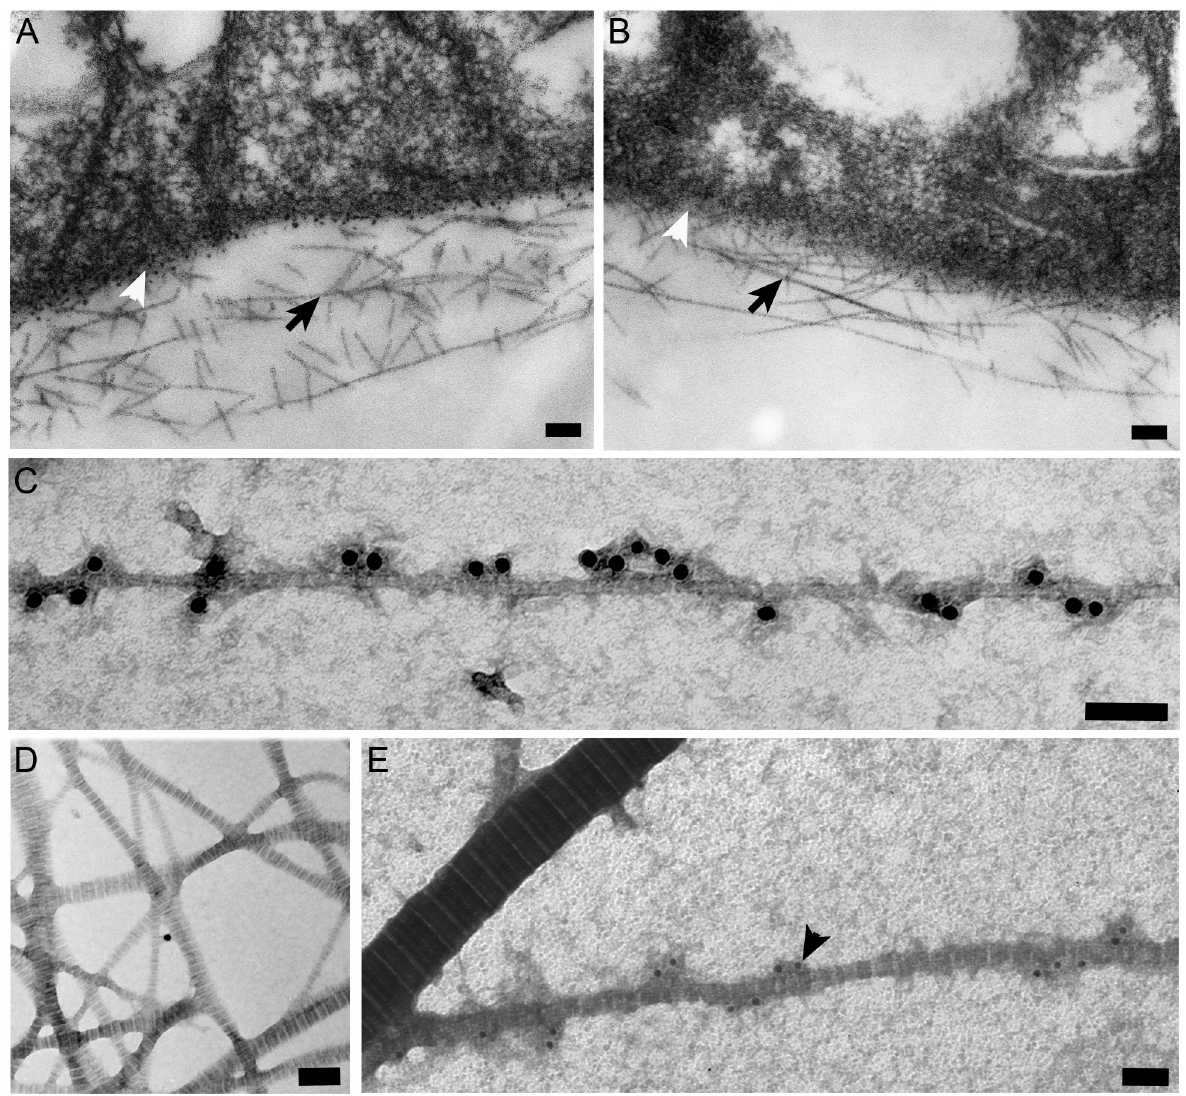
Fig 1. Ultrastructural analyses of vitreous and cartilage collagen fibrils. Electron microscopy of vitreous collagen fibrils (black arrows) from wild- type (A) and opticin null (B) mice showing morphological identity; there was no difference in mean fibril diameter (white arrow heads indicate inner retinal surface). (C-E) Opticin antibody in conjunction with 18 nm gold-conjugated secondary antibody demonstrates opticin on the surface of bovine vitreous collagen fibrils (C); endogenous opticin was not detected on cartilage collagen fibrils (D). Recombinant opticin added to cartilage fibrils in vitro was detected by immunogold labelling on the surface of thin (black arrowhead), but not thick fibrils (E, bars 100nm).